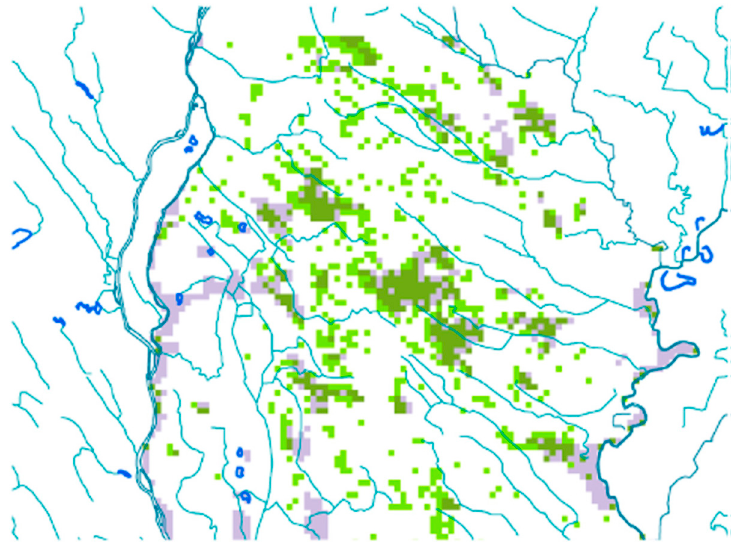
Figure 4. Groundwater discharge (i.e., estimated negative recharge) areas on the Sand Plateau of the Hungarian Great Plain. The map shows the frequent overlap of groundwater discharge areas (magenta) and of forest cover (light green). Overlapping areas are dark green. Rivers and ponds are marked dark blue (adapted from [44]).